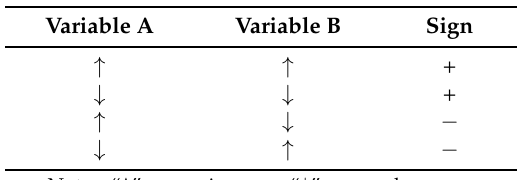
Notes: “ ↑ ” means increase; “ ↓ ” means